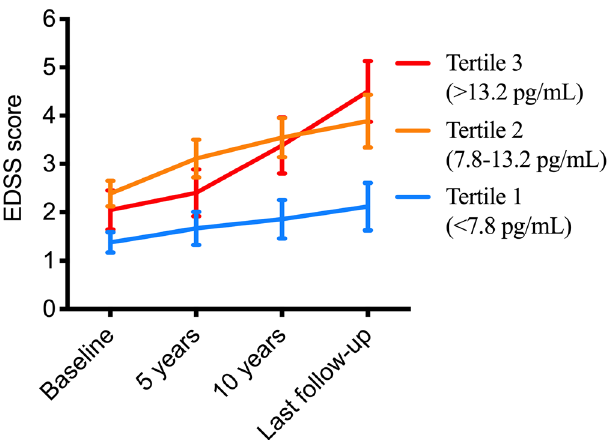
Figure 5. Baseline NfL tertile and EDSS trajectories. Trajectory of EDSS over long-term follow-up in subgroups of MS patients based on serum NfL tertiles at baseline (overall repeated measures ANOVA p = 0.031, df 2 F